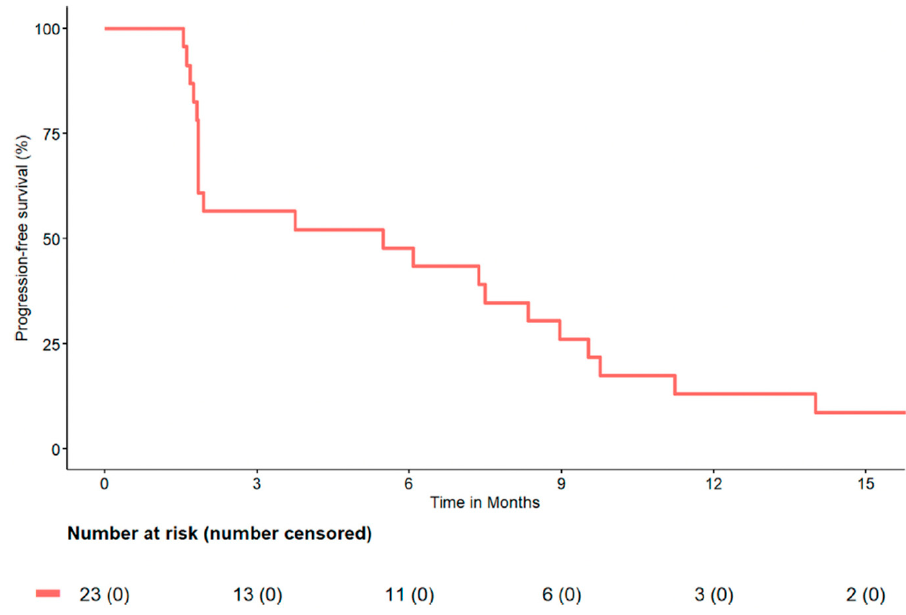
Figure 2. Kaplan–Meier curve of progression-free survival in patients receiving at least 2 cycles of regorafenib [20].